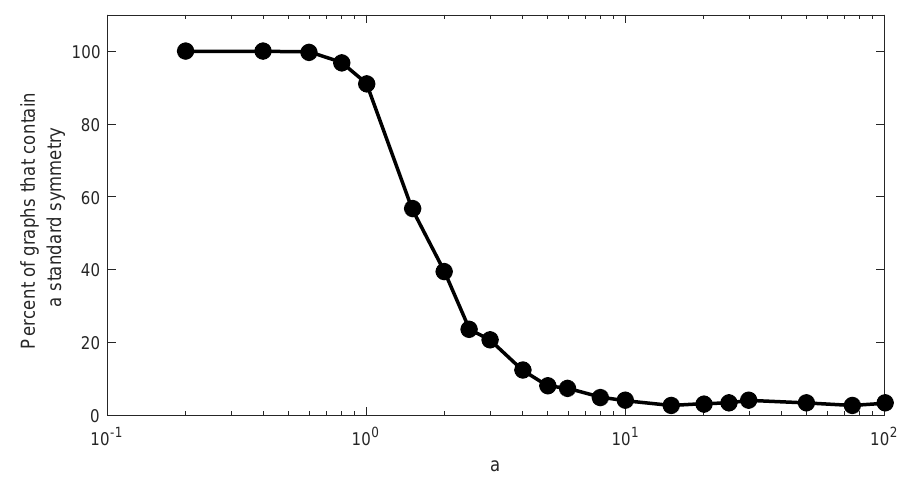
Fig. 5 The left figure plots the percentage of graphs which were generated using preferential attachment that contain a standard symmetry. The horizontal axis (plotted logarithmically) gives di ff erent values of a , the parameter which controls how strongly each edge is attached preferentially. The right is the same figure in which the occurrences of latent symmetries are